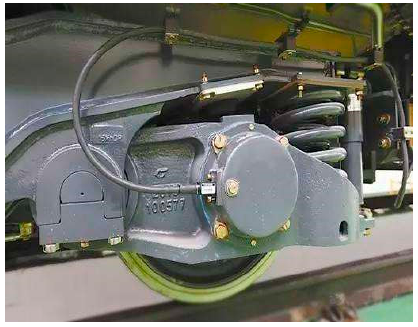
Figure 5. Physical map of train odometer.